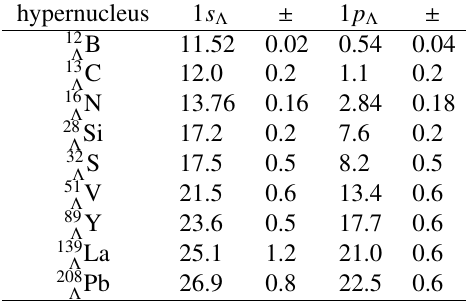
Table 1. Binding energies in MeV, including uncertainties, considered here; taken from Table IV of Ref. [3].